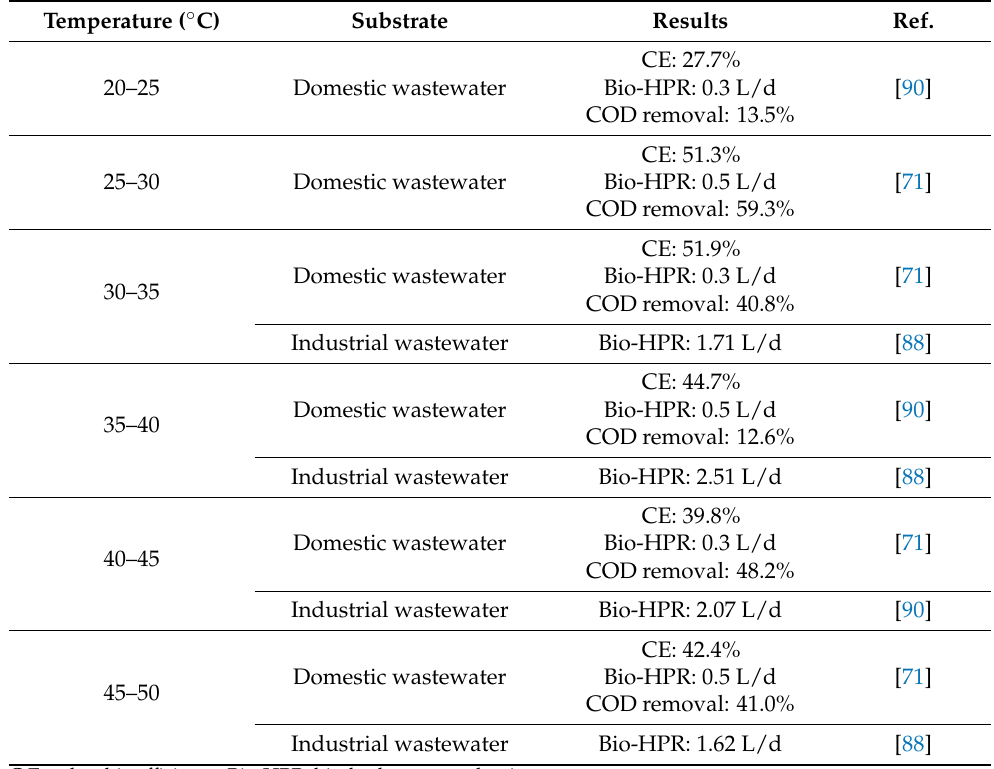
Table 5. Effect of temperature ( ◦ C) on performance of